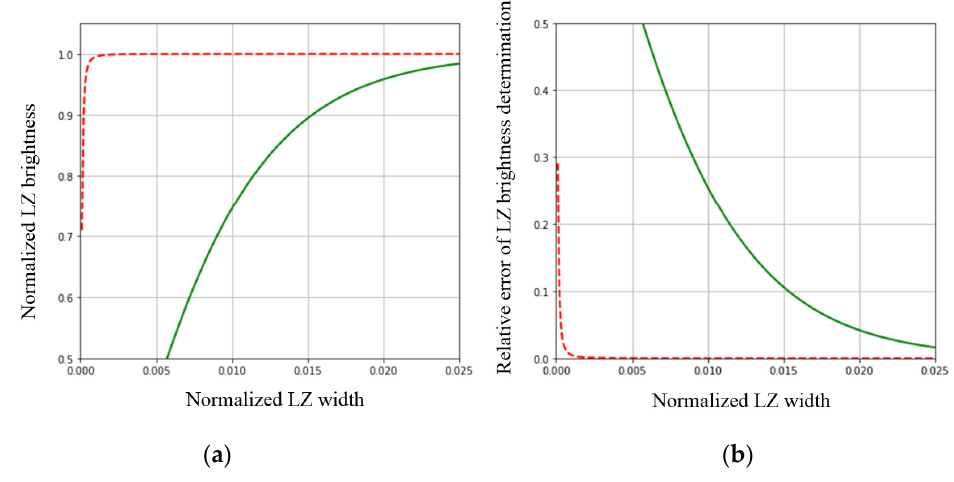
Figure 9. Results of the reconstruction of the light zone brightness by the video signal v ( ˆ t ) (solid line—the conventional method for the reconstruction by the signal v ( ˆ t ) ; dashed line—the reconstruction with the use of SSPs): ( a ) the dependence of the measured values of the normalized brightness of the light zone on the real values of its normalized width; ( b ) relative error of the LZ brightness determination depending on the real value of its normalized width.